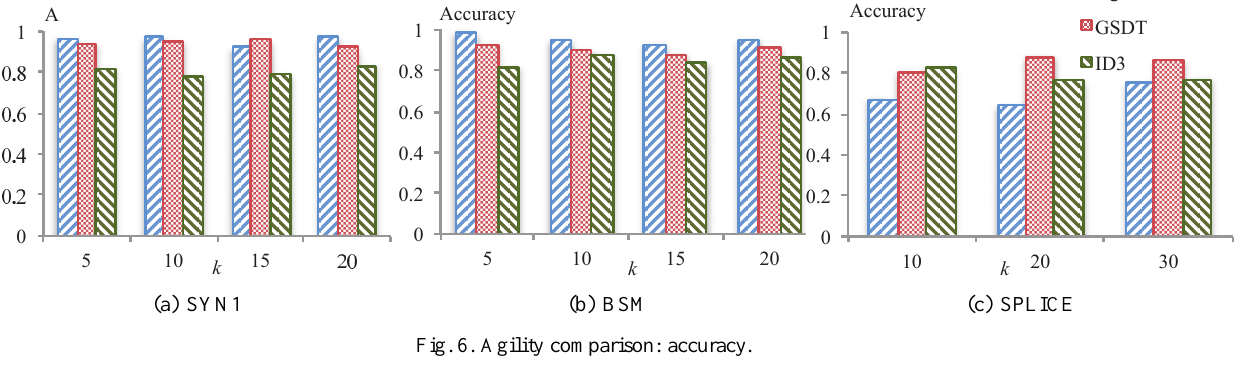
Fig. 6. Agility comparison: accuracy.